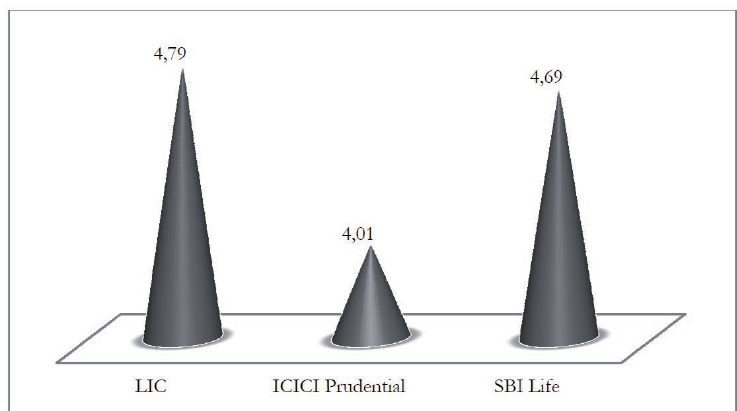
Fig. 5 - Customer Loyalty in Life Insurance (Company Wise). Source: own